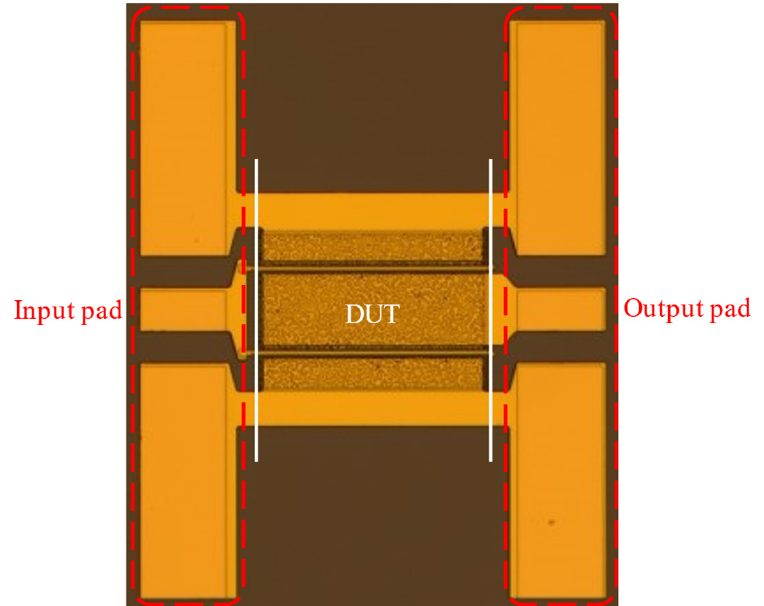
Figure 4. Device under test (DUT) and the input and output coplanar waveguide (CPW) pads.